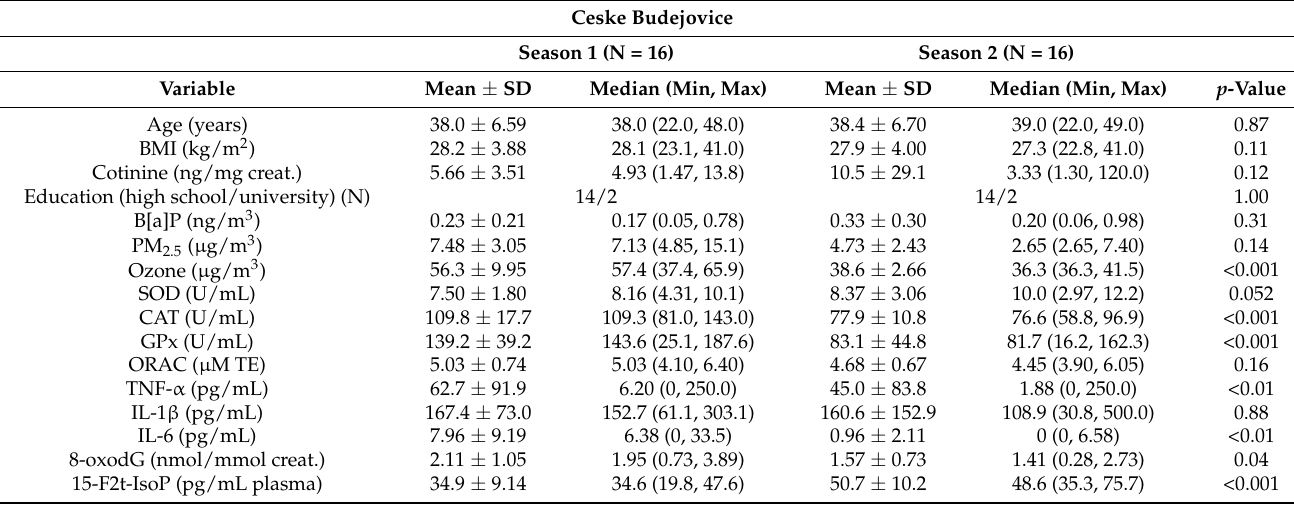
Table 1. Characteristics of the study population, exposure to environmental pollutants, parameters of antioxidant and immune response, and oxidative stress markers: locality Ceske Budejovice; SD–standard deviation.